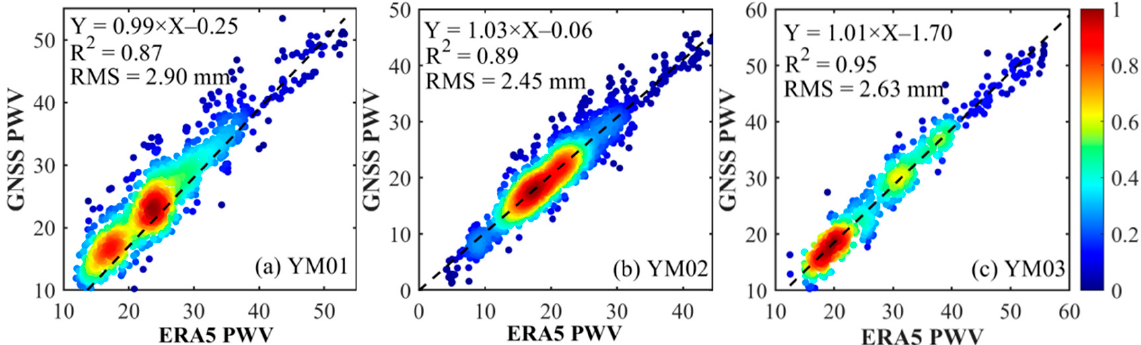
Figure 3. Probability density maps of PWV at the three GNSS stations in Yunmao from November